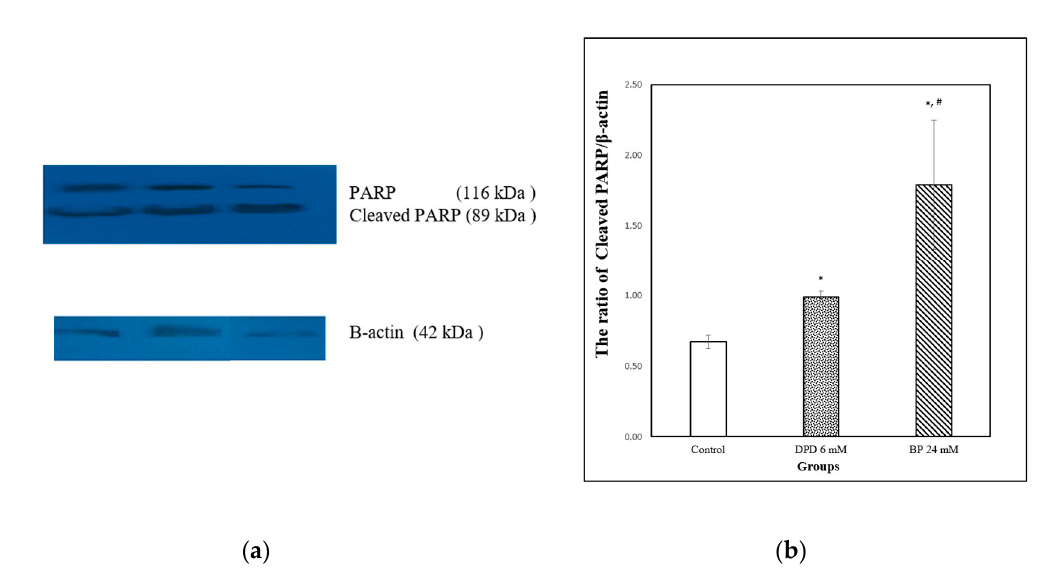
Figure 3. ( a ) Western blot analysis of PARP, cleaved PARP levels on control, DPD (6 mM) and BP (24 mM) treated HL-60 cells, respectively. ( b ) Comparison of the cleaved PARP/ β -actin ratio (mean ± SD) among the groups, p <